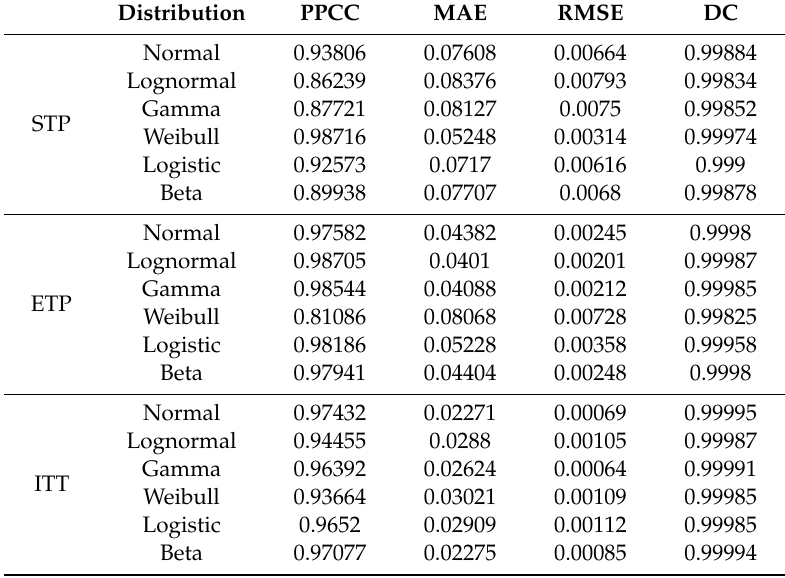
Table 5. Goodness-of-fit tests for start time of the plum rain period (STP), plum rain period (ETP), and initial time when typhoon begins to a ff ect the Taihu Basin